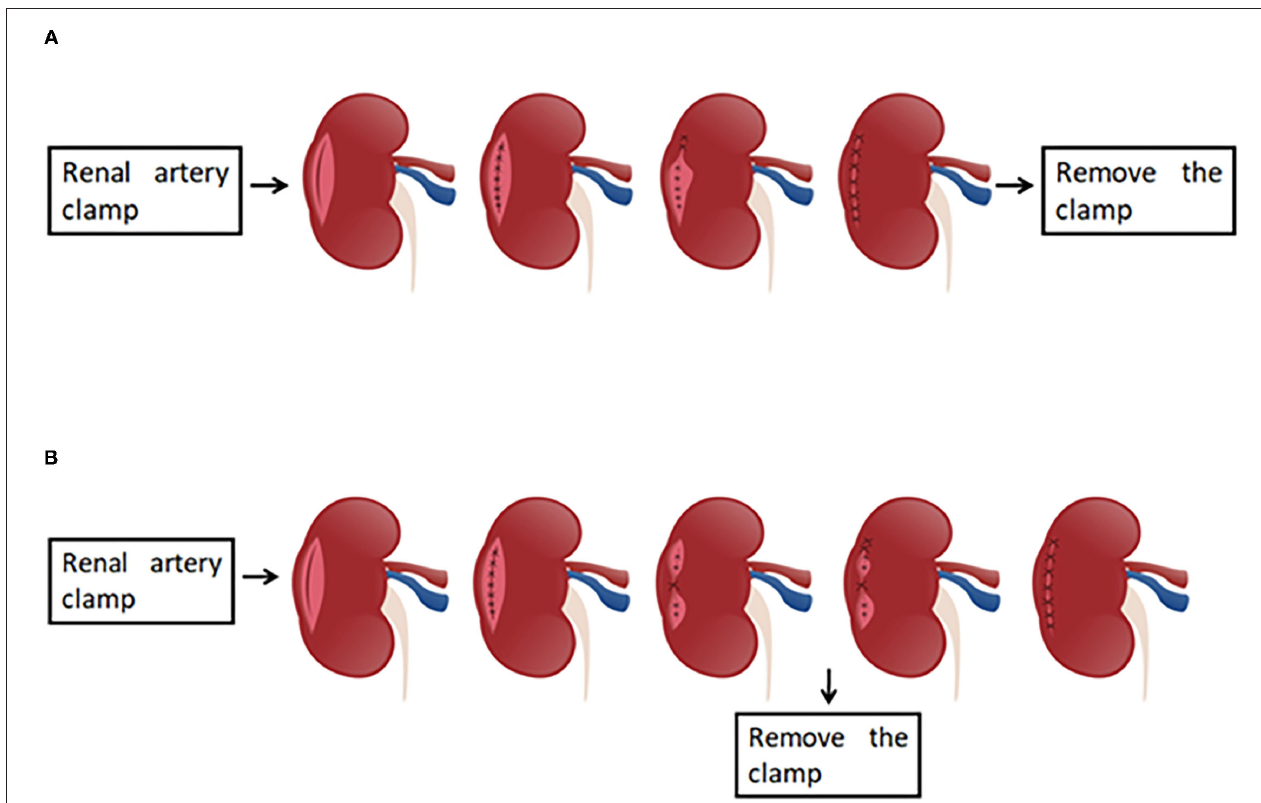
FIGURE 1 | The presentation of the traditional two-layer suture and modified two-layer suture. (A) The graphical representation of the traditional two-layer suture. After the renal artery is clamped, the suture is done in the base (inner layer), and subsequently the sutures are run from one end of the outer layer to the other end, the clamp is removed at last. (B) The presentation of the modified two-layer suture. The steps are same as those in traditional suture method until the inner layer suture is finished. When the suture for outer layer is performed, the first suture is initiated at the central point of the outer layer, and the tail of the suture was secured by Hem-o-Lok clips. Consequently, one side of the outer layer was attached closely to another side so that the potential hemorrhagic spots were pressed. Then, the vascular clamp is removed to restore kidney perfusion, and the sutures are continuously run from top to bottom.